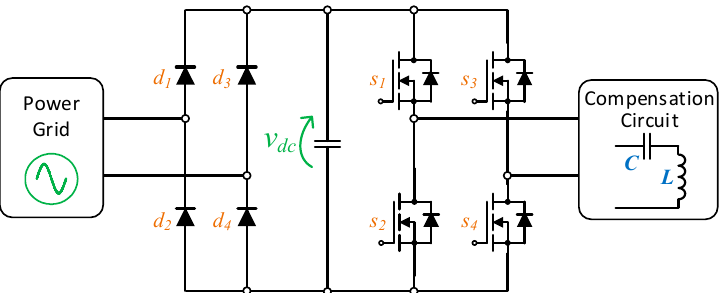
Figure 6. Full-bridge rectifier in conjunction with an H-bridge DC-AC converter to interface the power grid with the compensation circuit and transmitter coil.